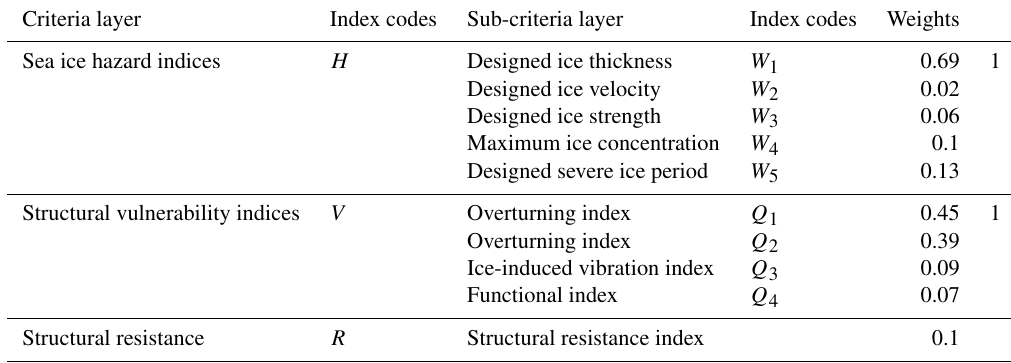
Table 7. Hierarchical structure and weights of sea ice risk assessment factors for the overall risk assessment.